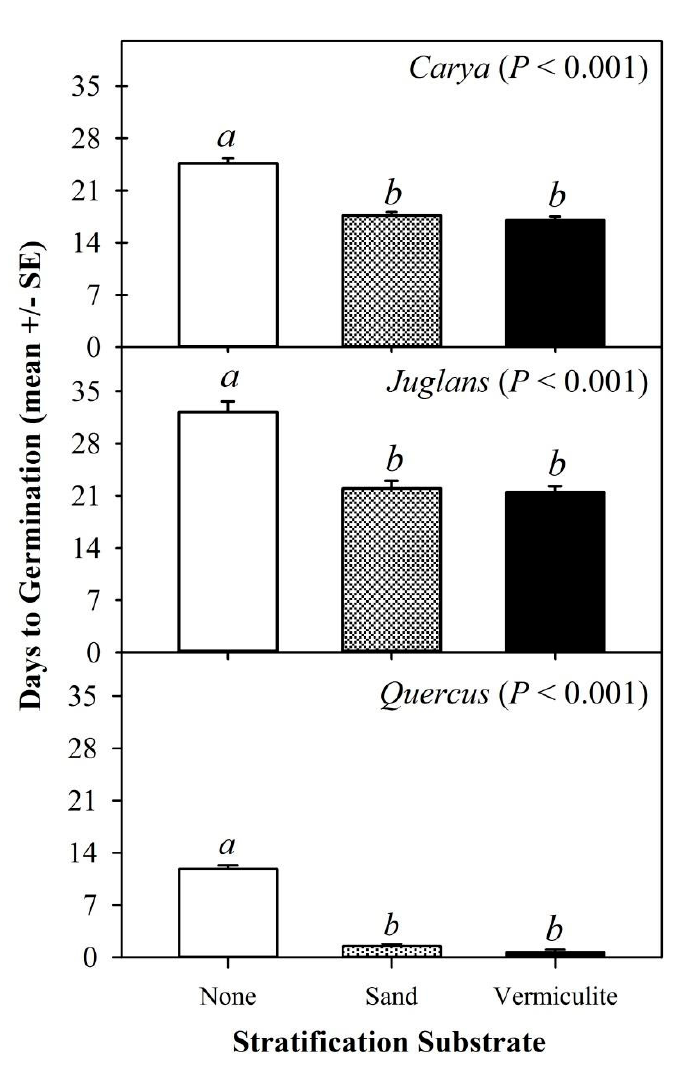
Figure 3. Influence of germination substrate on time to germination (days) of Carya lacioniosa , Juglans cinerea , and Quercus rubra seeds stratified in sand, vermiculite or without media. P -values of full model analysis of variance are shown and letters indicate differences suggested by post-hoc comparisons within species.